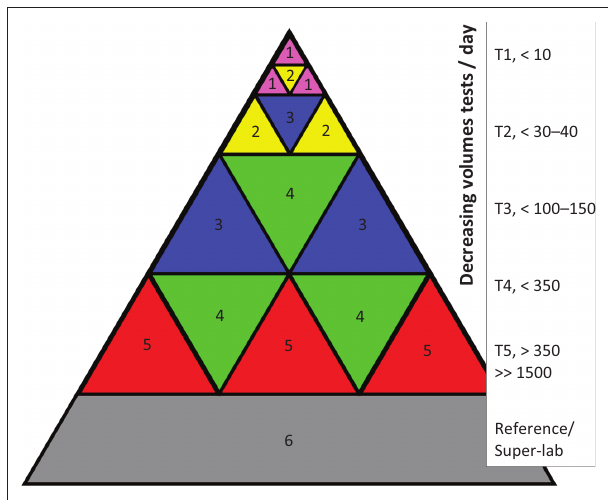
FIGURE 2: Integrated Tiered Service Delivery Model. The proposed NHLS CD4 tiered laboratory network structure comprises six service tiers, which support decreasing service test volumes in increasingly remote sites. Tier 1 (servicing a single site) and Tier 2/‘POC Hub’ (servicing up to 10 remote clinics) utilise multiple POC technologies to extend laboratory services (HIV, tuberculosis) in remote, hard-to-reach areas, beyond a reasonable distance to a Tier-3 laboratory; Tier 3 represents a community laboratory that serves > 10 < 50 clinic sites; Tier 4 and Tier 5 are regional laboratories